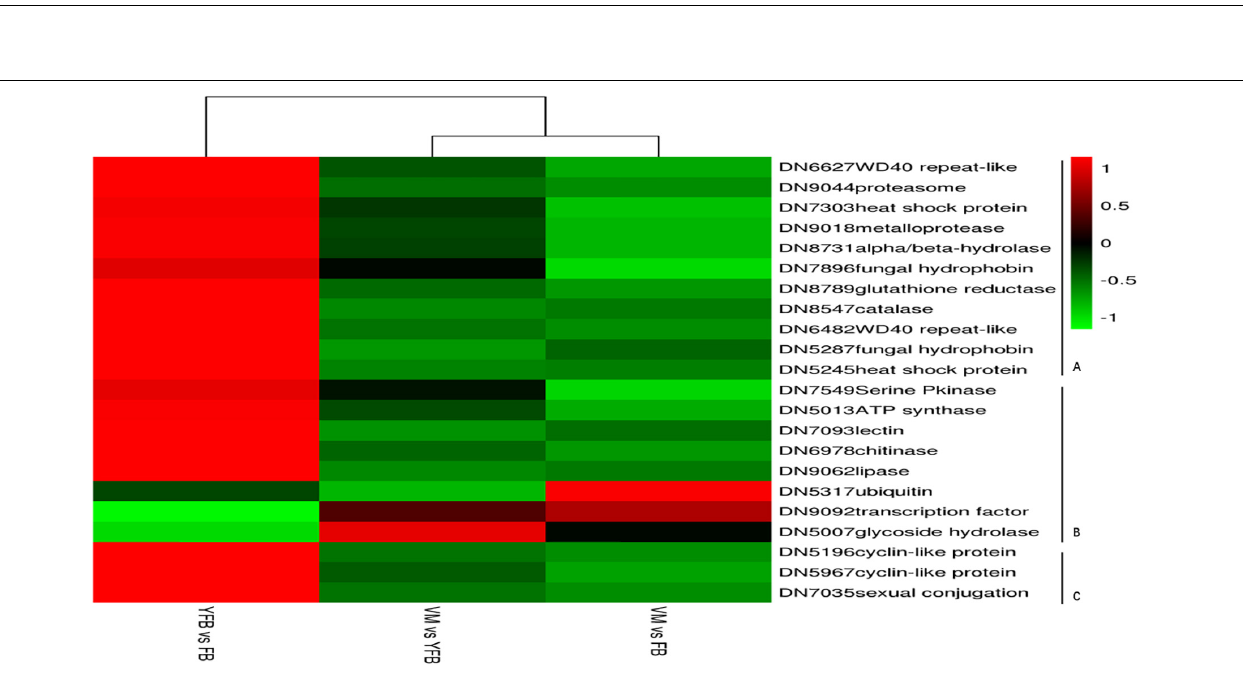
Frontiers in Microbiology |